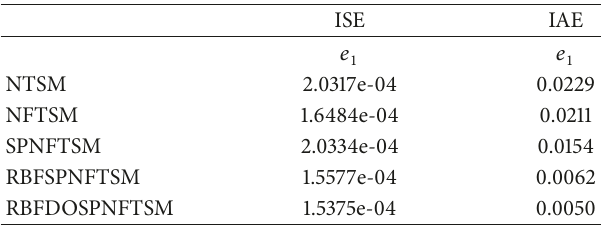
Table 3: Performance index values of the inverted pendulum